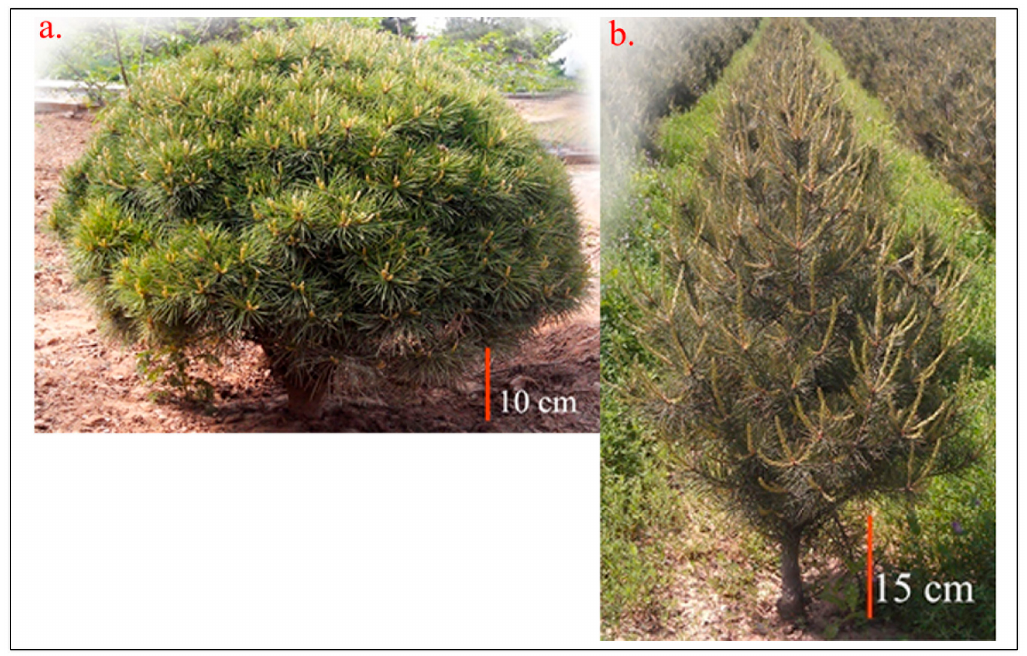
Figure 1. The plant morphology of two Pinus bungeana varieties. ( a ) The new variety named Penxian; ( b ) the ordinary variety named ’Tree No. 9’.